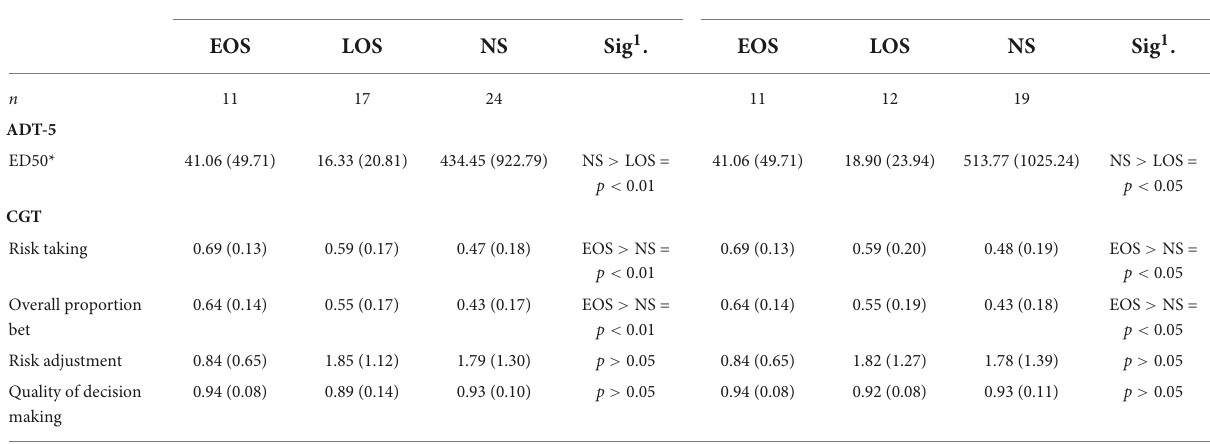
TABLE 3 Impulsive choices and risky decision-making